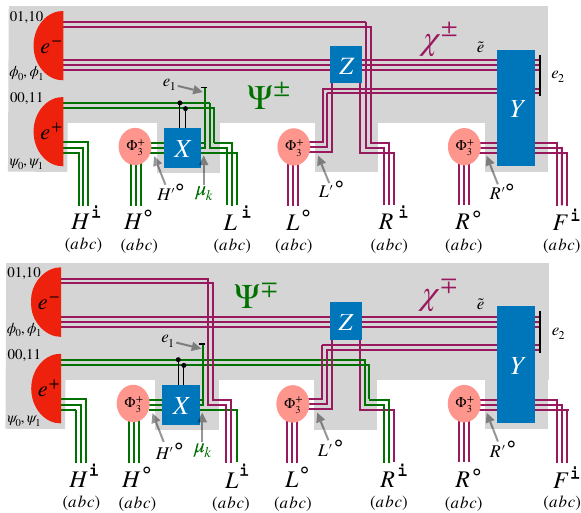
FIG. 33. (Quantum) Markov order network. A process with finite quantum Markov order with parts of M kept by H and F . The top panel shows the first process, in which parts of the common cause state | e + (cid:16) is sent to L i and | e − (cid:16) is sent to R i . The process in the bottom panel has the recipients flipped. The process tensor is depicted in gray, and entanglement between par- ties are color coded in green and maroon. The overall process is a probabilistic mixture of both scenarios. Still the process has finite Markov order because it is possible to differentiate between the scenarios by making a parity measurement on M